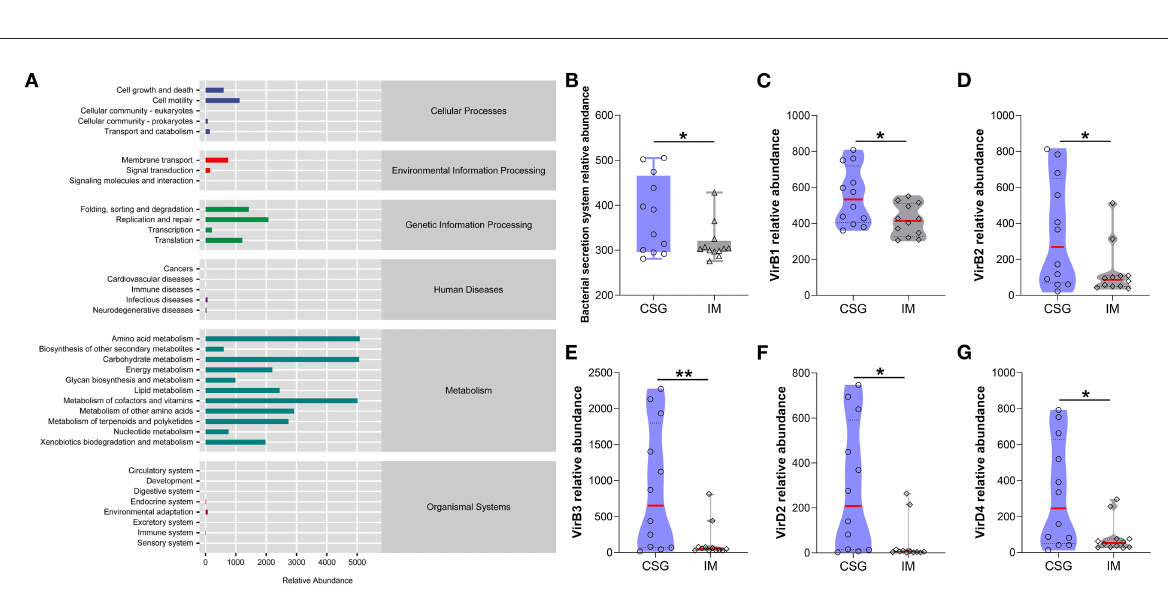
of non-cardiac GC in a lifetime (Yang et al., 2022).